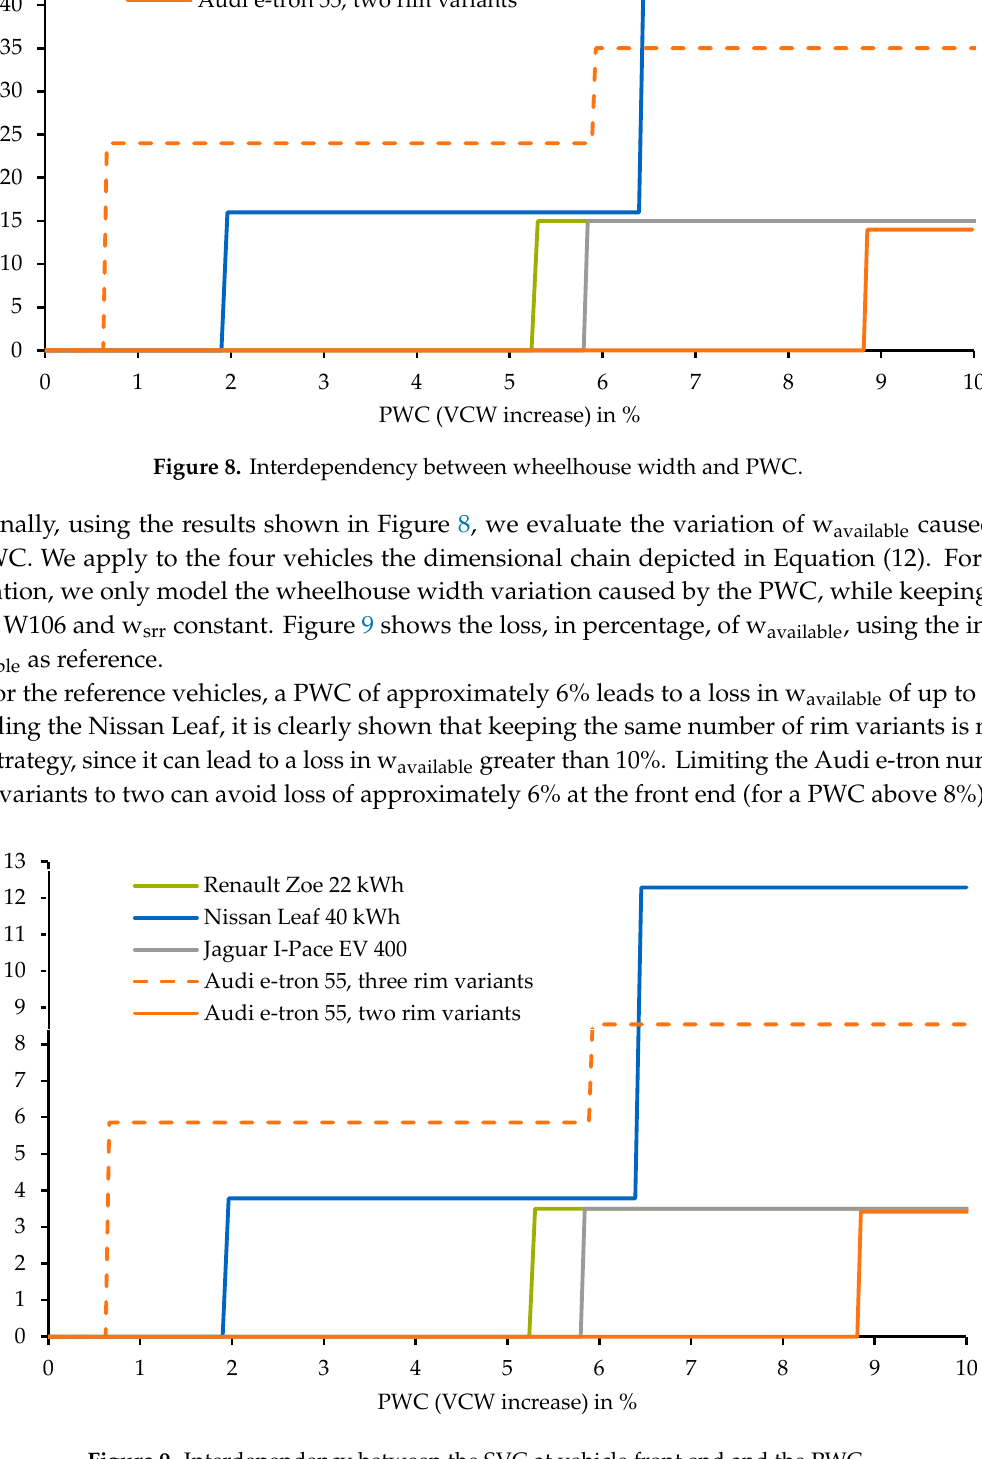
Figure 9. Interdependency between the SVC at vehicle front end and the PWC.